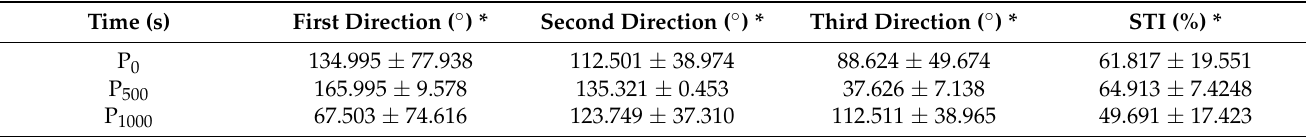
Table 4. Surface texture isotropy (STI) and the respective directions.